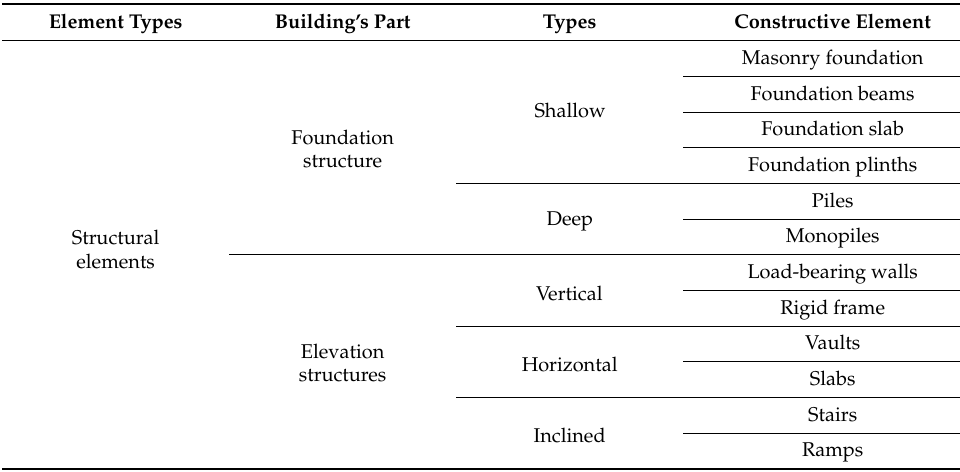
Table 3. Building’s structural and non-structural